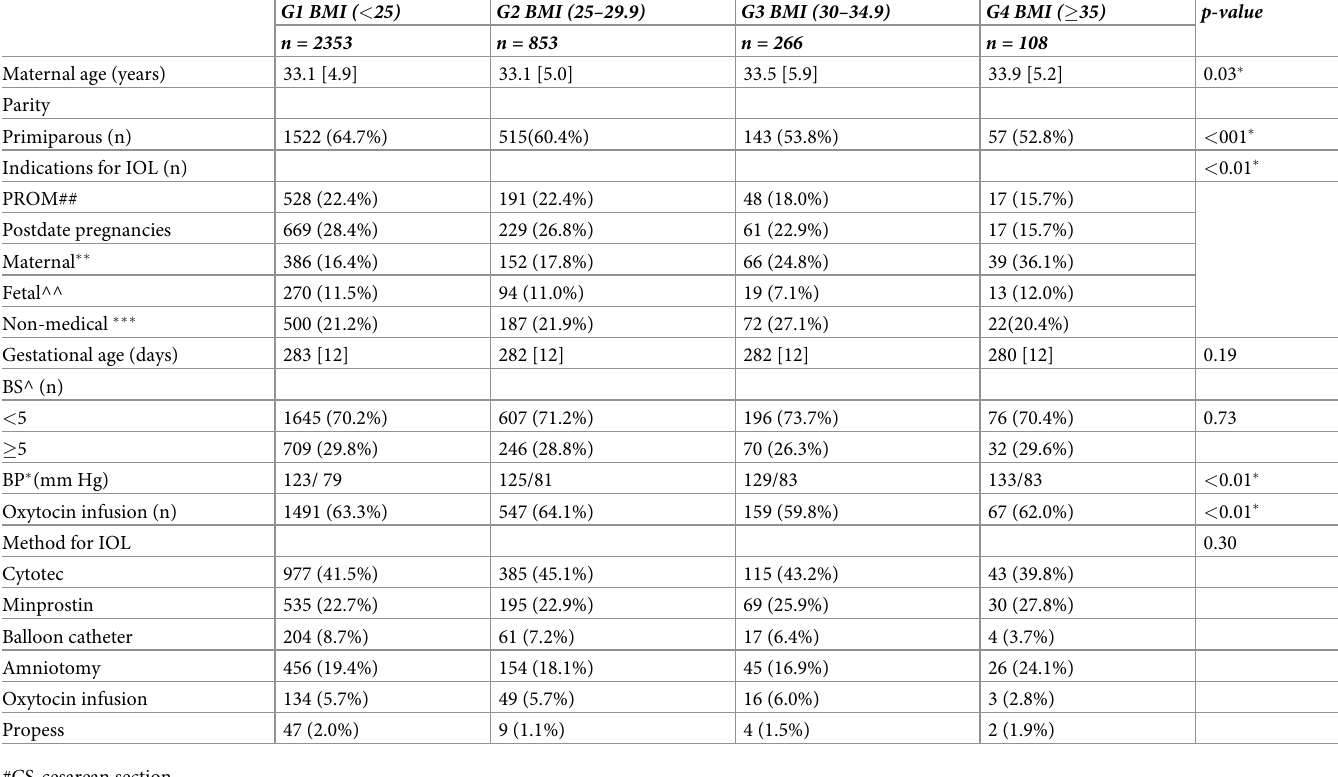
Table 1. Maternal baseline data. Women who underwent induction of labor (IOL) (n = 3772) grouped according to BMI (G1-G4). Data are presented as numbers (%) or mean (standard deviation [SD]). P-values < 0.05 were considered statistically significant �